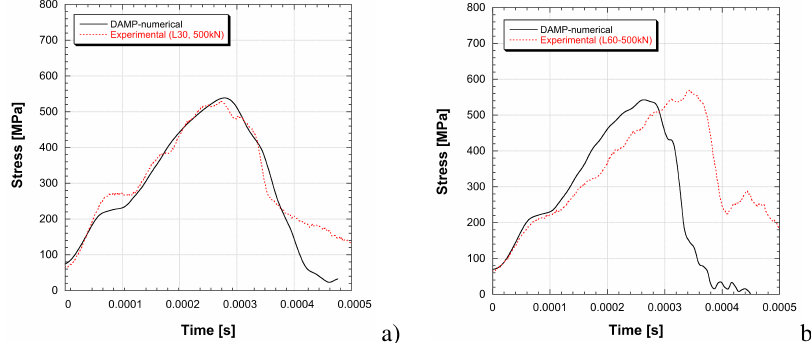
Figure 6. Comparison between numerical and experimental resutls: a) 30mm; b) 60mm specimen.